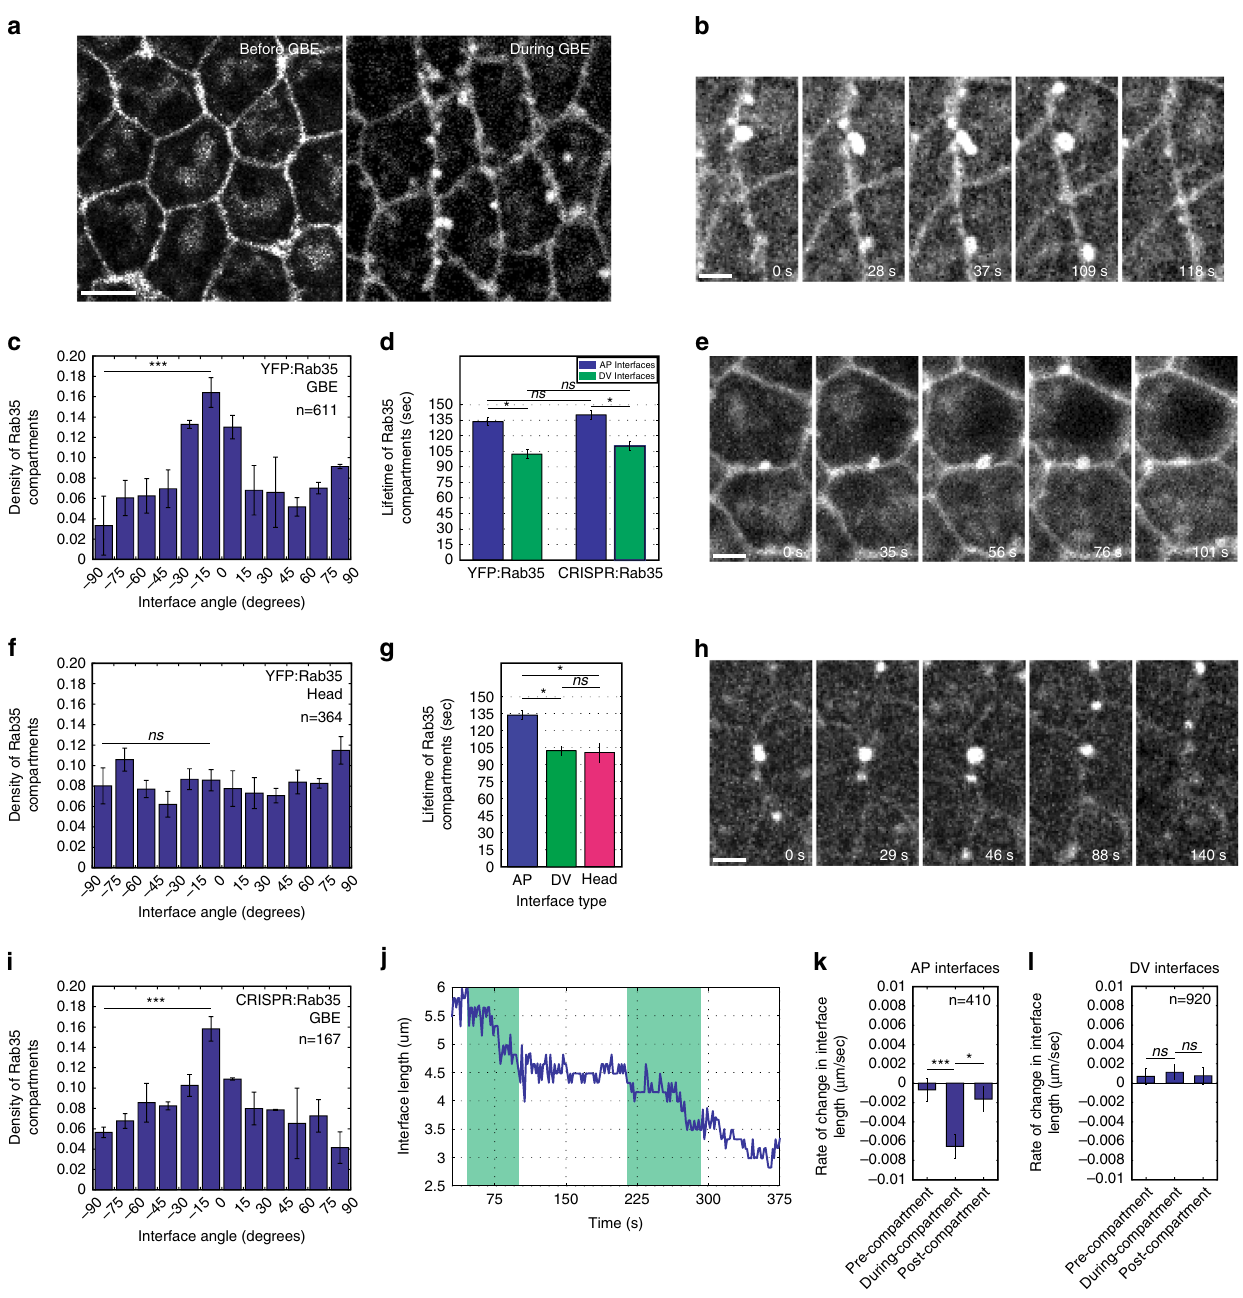
Fig. 1 Planar polarized Rab35 compartments associate with AP interfaces during periods of active interface contraction. a , b Time-lapse images of embryo expressing YFP:Rab35. All images, anterior is to the left and ventral is down . a YFP:Rab35 compartments localize to AP cell interfaces after GBE begins ( right image ). b Representative images depicting the life cycle of a Rab35 compartment: initiation of YFP:Rab35 compartment (0 s), growth phase (28 s), maximum compartment size (37 s), shrinkage (109 s), and compartment termination (118 s). c Rab35 compartments occur more frequently at AP interfaces. Compartment density plotted as a function of binned interfaces angles in the germband ( n = 611 compartments). d YFP:Rab35 compartment lifetimes are longer at AP interfaces ( n = 205 compartments). Endogenous CRISPR:GFP:Rab35 displays similar lifetimes to YFP:Rab35 ( n = 170 compartments). e – g YFP:Rab35 compartments in the non-intercalating head region ( e ) show an absence of planar polarity ( f ) and lifetimes comparable to DV-localized Rab35 ( g ) ( n = 364 ( f ) and 198 ( g ) compartments). h , i At endogenous levels, CRISPR:GFP:Rab35 demonstrates similar compartmental dynamics ( h ) and planar polarity ( i ) to YFP:Rab35, although non-compartmental plasma membrane localization of Rab35 is reduced ( h ) ( n = 167 compartments). j Rab35 compartments are associated with periods of interface contraction. Automated segmentation analysis and compartment recognition showing a plot of interface length over time with association of YFP:Rab35 compartments shaded in green . k , l Decreases in AP interface length strongly correlate with the presence of Rab35 compartments. Rate of change in interface length 30 s before initiation of Rab35 compartment (pre-compartment), during the lifetime of a Rab35 compartment (during-compartment), and 30 s after termination of a Rab35 compartment (post-compartment). AP interfaces show signi fi cant decreases in interface length during the lifetime of Rab35 compartments ( k ), whereas DV interfaces show no signi fi cant changes in interface length ( l ). Negative values indicate contractions in interface length. Student ’ s t -test, * P < 0.05, ** P < 0.005, *** P < 0.0005. Error bars indicate standard error. Scale bar in a is 5 microns. Scale bars in b , e , h are 2.5